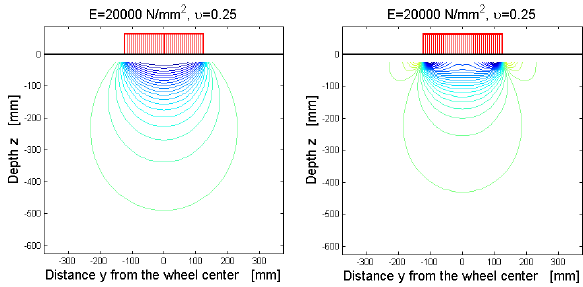
Figure 22: σ z contours on the A-A vertical cross-section of Figure 21: Boussinesq’s solution on the left and the second order solution on the right.